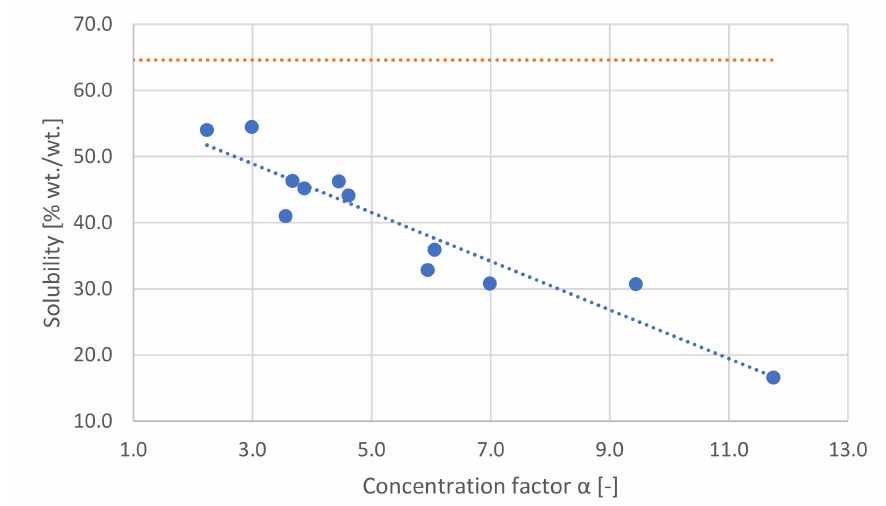
Figure 5. Solubility of the product as function of the concentration factor of soluble impurities / byproducts during multi-stage crystallization at 60 ◦ C in aqueous solution (blue) and the solubility of the product in pure water at 60 ◦ C